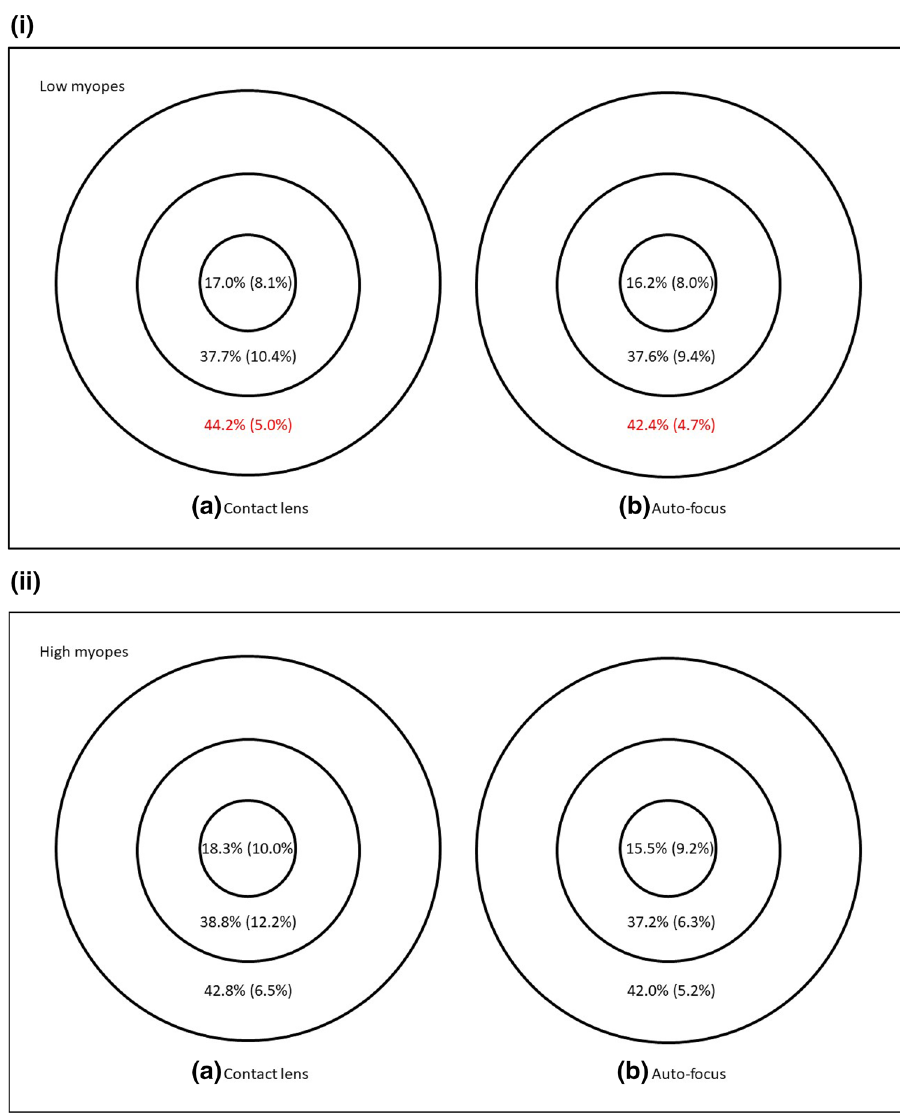
Figure 5. ( i ) Perfusion density of 34 eyes from low myopes when corrected with ( a ) contact lens and ( b ) the auto-focus system. Results are expressed as median (interquartile range) using the ETDRS central circle, inner and outer rings of the 6 mm grid. Significant difference between the two correction methods is marked in red. ( ii ) Perfusion density of 34 eyes from high myopes when corrected with ( a ) contact lens and b) the auto-focus system. Results are expressed as median (interquartile range) using the ETDRS central circle, inner and outer rings of the 6 mm